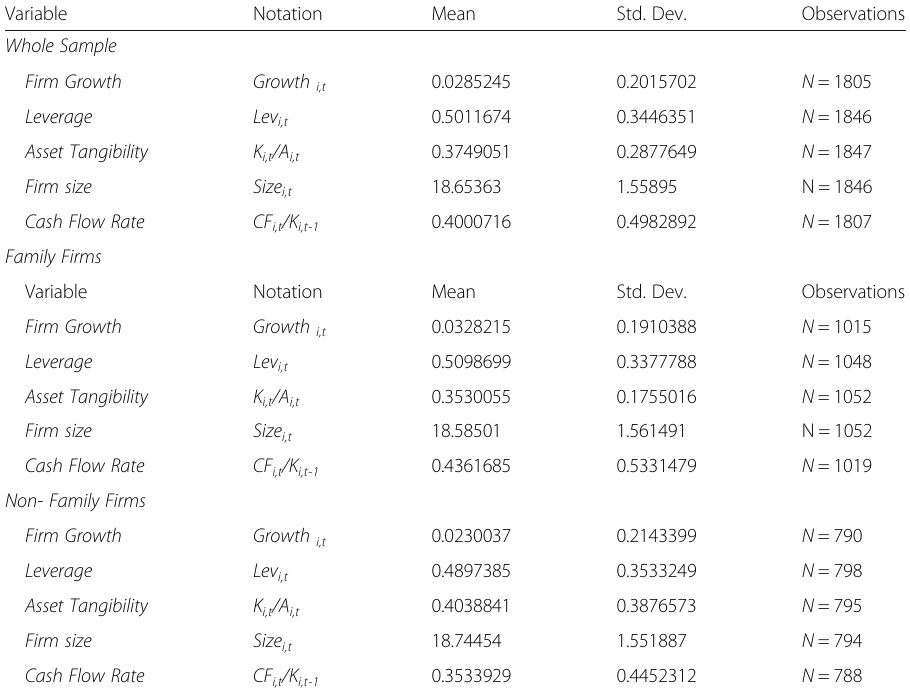
Table 2 Descriptive